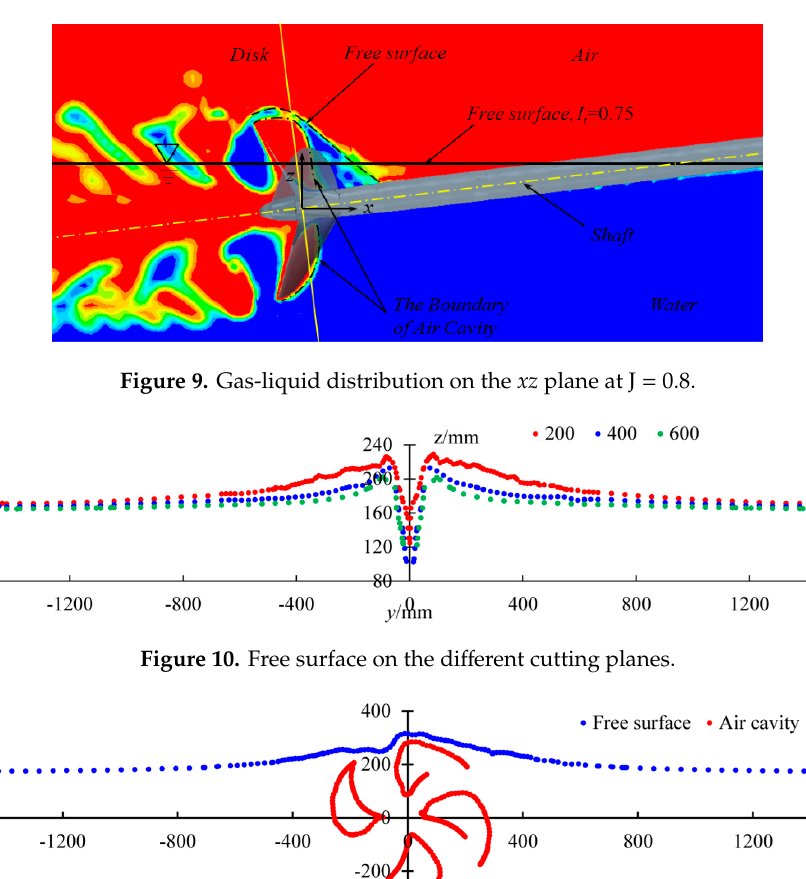
Figure 9. Gas-liquid distribution on the xz plane at J = 0.8.